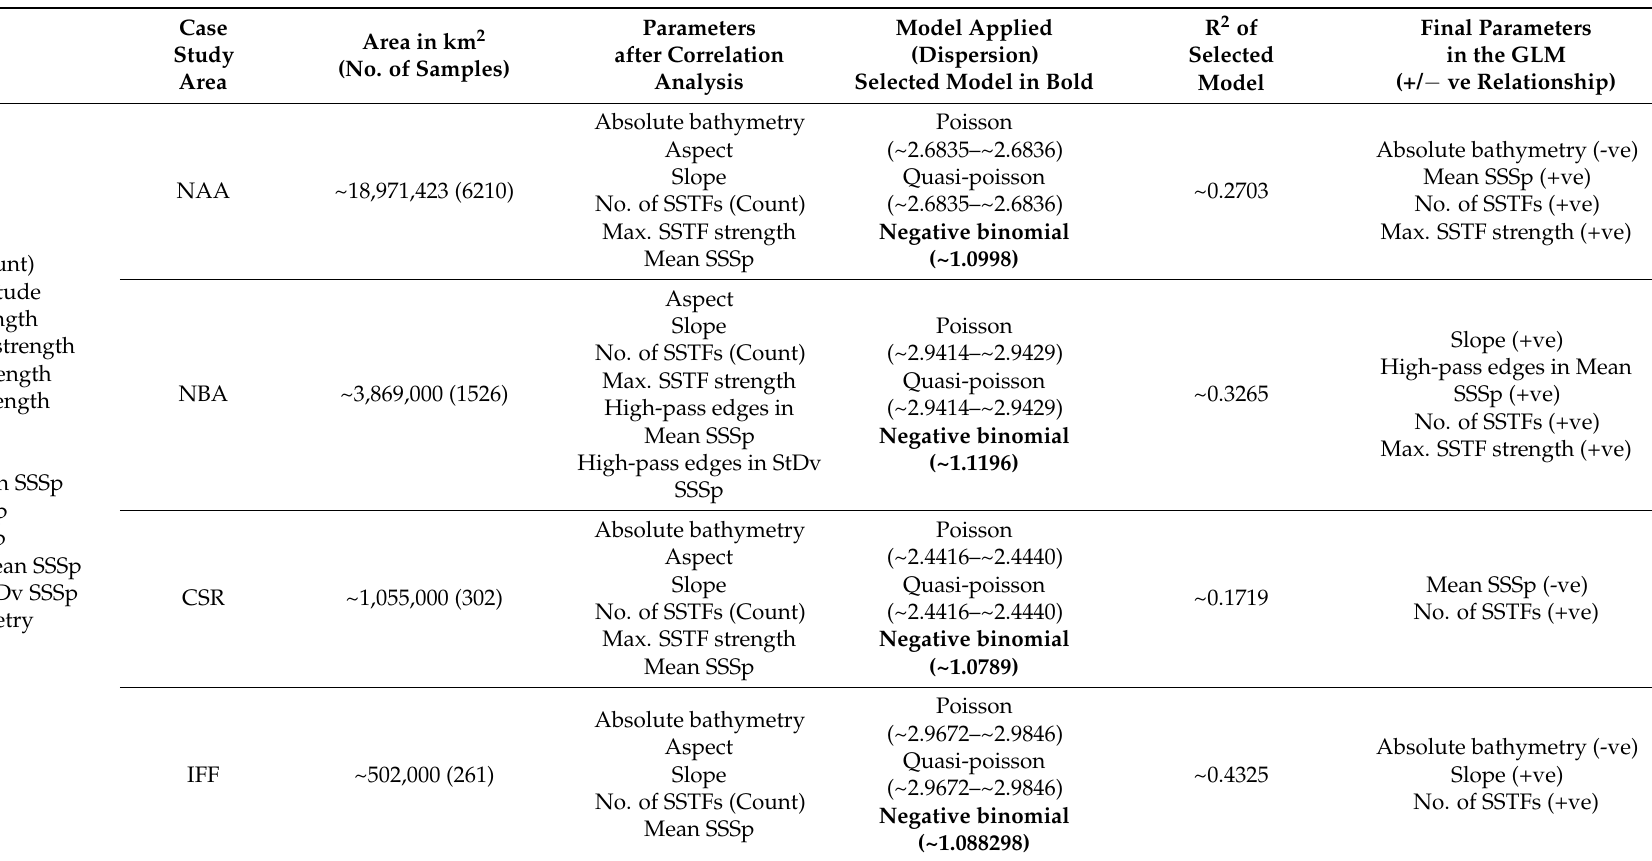
Table A1. Details of each case study’s Generalised Linear Model development. Information includes each case study’s area (estimated using the WGS 84 Web Mercator projection